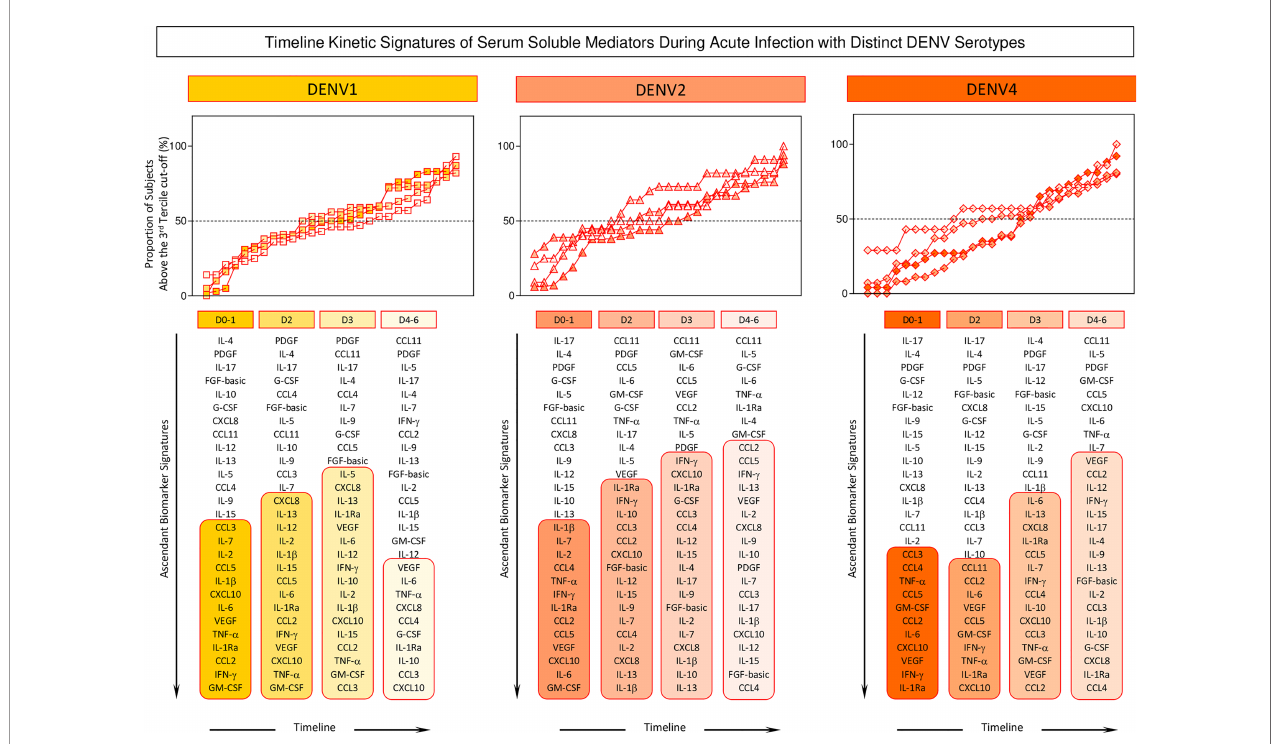
FIGURE 6 | Timeline kinetics signatures of serum soluble mediators during acute infection with distinct DENV serotypes. Overall signature of chemokines (CXCL8, CCL11, CCL3, CCL4, CCL2, CCL5, CXCL10), pro-in fl ammatory cytokines (IL-1 b , IL-6, TNF- a , IL-12, IFN- g , IL-15, IL-17), regulatory cytokines (IL-1Ra, IL-4, IL-5, IL- 9, IL-10, IL-13), and growth factors (FGF-basic, PDGF, VEGF, G-CSF, GM-CSF, IL-7 and IL-2) were assembled for patients with acute infection with distinct DENV serotypes (n=265), referred to as: DENV1 ( n=114), DENV2 ( n=52), and DENV4 ( n=99) by cross-sectional analysis at four consecutive time points (Days = D), including: D0-1 (n=42; 17; 26), D2 (n=40; 18; 36), D3 (n=17; 11; 30) and D4-6 (n=15; 6; 7) after symptom onset. The serum soluble mediators were measured by a high-throughput microbeads array as described in Material and Methods. Signatures of serum soluble mediators were built by fi rst converting the serum levels of soluble mediators, originally expressed as continuous variables (pg/mL) into categorical data (percentual, %) using the upper 3 rd tertile values of each serum mediator as the cut-off to identify the proportion of subjects above the cut-off edges. The fi nal data are shown as line charts displaying the serum soluble mediator signature at each time point. Column diagrams are provided below to underscore the upregulated soluble serum mediators along the timeline kinetics. The 50 th percentile was used to underscore the serum soluble mediators with an increased proportion ( ≥ 50%) in each study